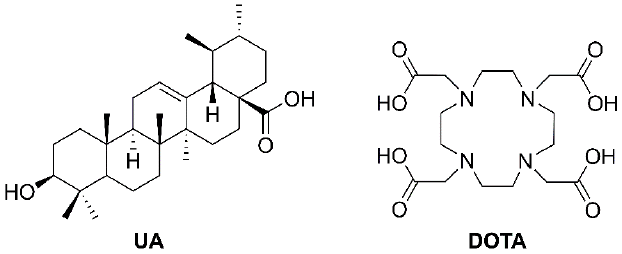
Figure 1. Structures of ursolic acid (UA) and 1,4,7,10-tetraazacyclododecane-1,4,7,10-tetraacetic acid (DOTA).